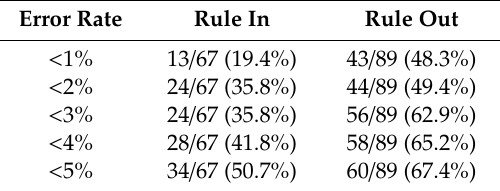
Table 4. Numbers (percentages) of lesions classifiable with defined error rates.